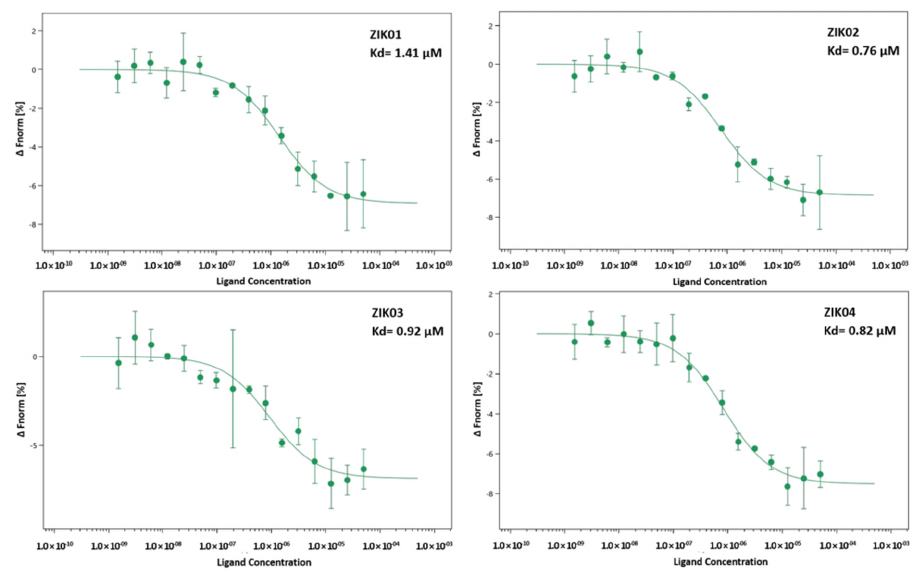
Figure 10. Thermophoretic assay to compare affinity between aptamers and E-ZIKVre protein. MST parameters: target concentration: 20 nM; ligand concentration: 50 µM–0.00153 µM; excitation power: 76%; temperature: 25 °C.